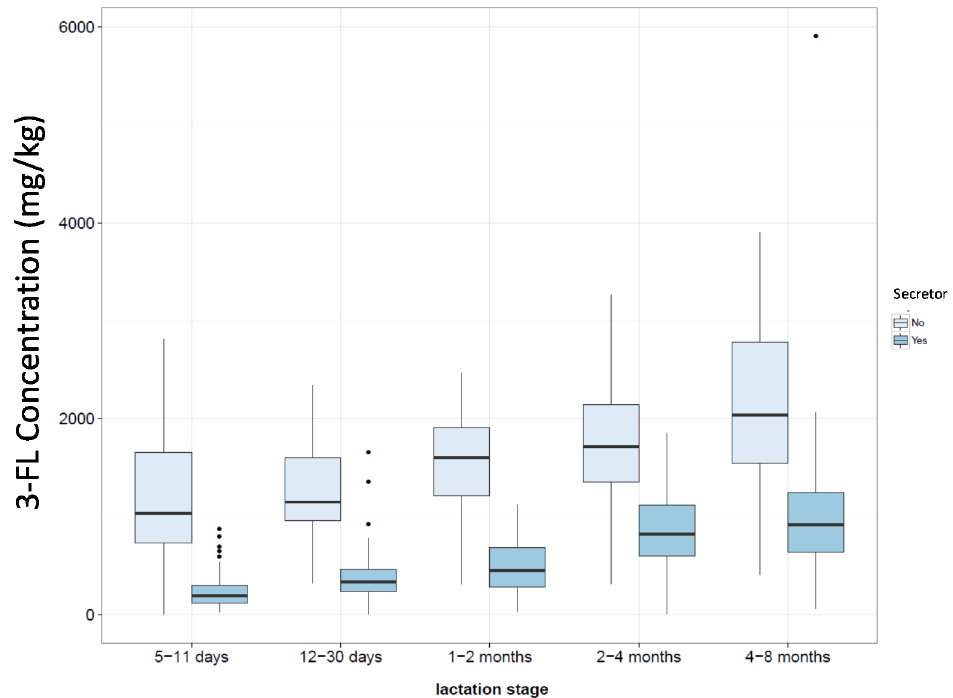
Figure 3. 3 ‐ FL concentration in milk samples comparing secretor vs. non ‐ secretor milk, where non ‐ secretor status has been assigned to samples having 2 ′‐ FL content below the method LoQ.